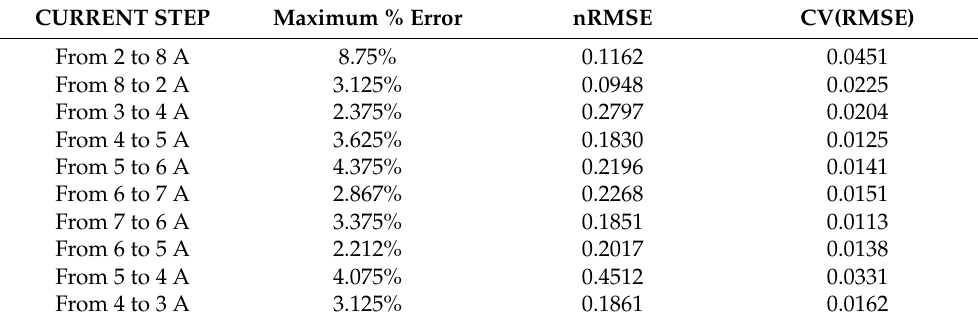
Table 4. Comparison among errors between voltage profiles obtained by the emulator and by the